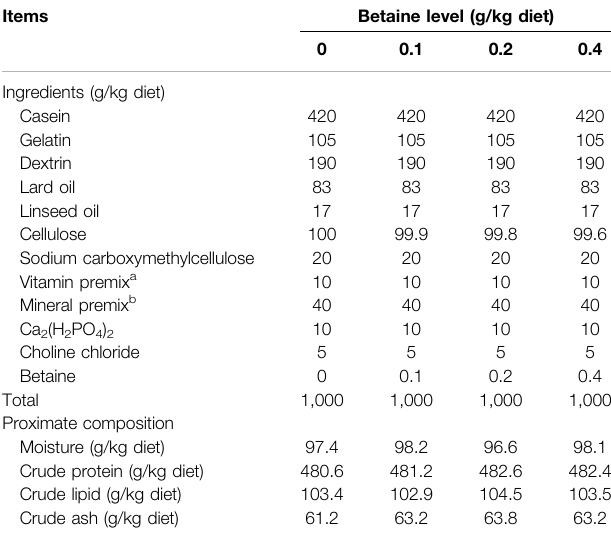
TABLE 1 | Composition and proximate analysis of the experimental diets.